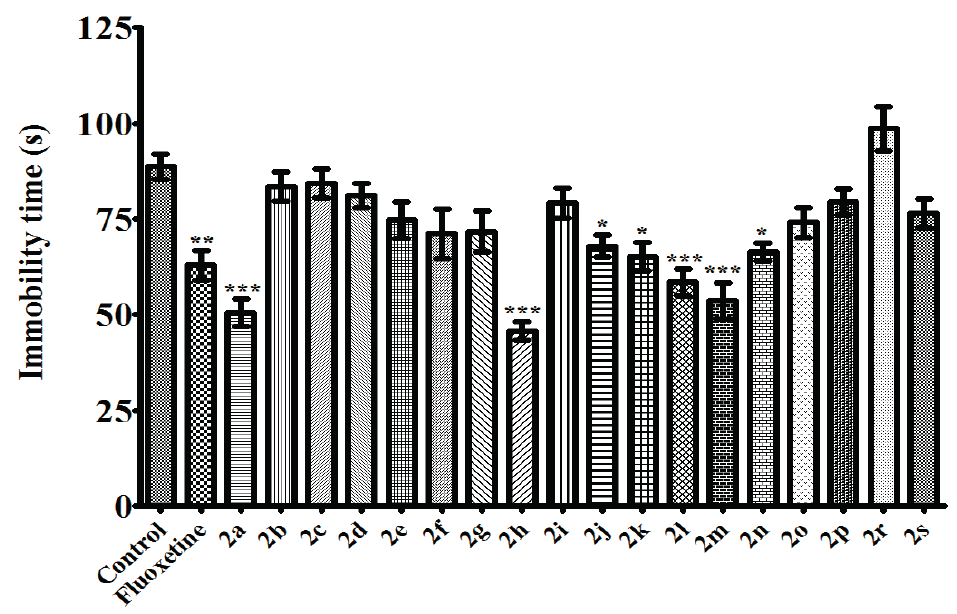
Figure 2. Effects of test compounds (100 mg/kg) and fluoxetine (10 mg/kg) on immobility time of mice in MFST. Significance against control values * p < 0.05, ** p < 0.01, *** p < 0.001. Values are given as mean ± SEM. One-way ANOVA, post-hoc Tukey’s test, n = 7.